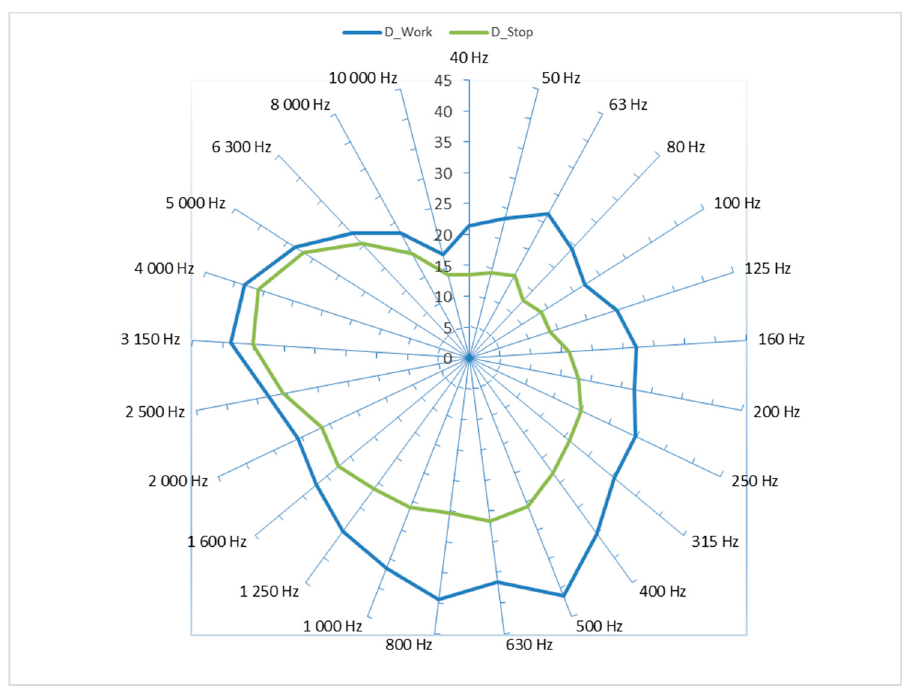
Figure 8. Values of noise emissions measured in residential areas I and II during operation (Work) and out of operation (Stop)—residential house D.